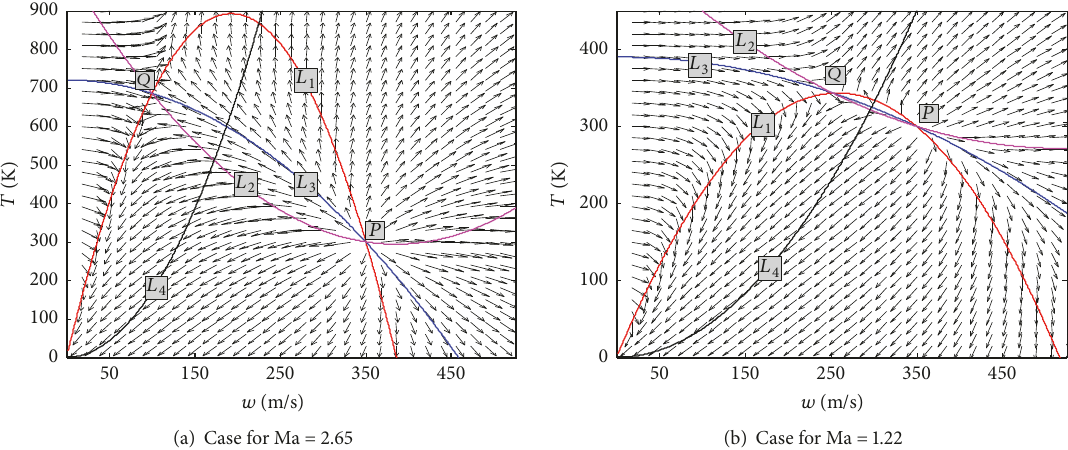
Figure 3: Direction field in the phase diagram for Pr =